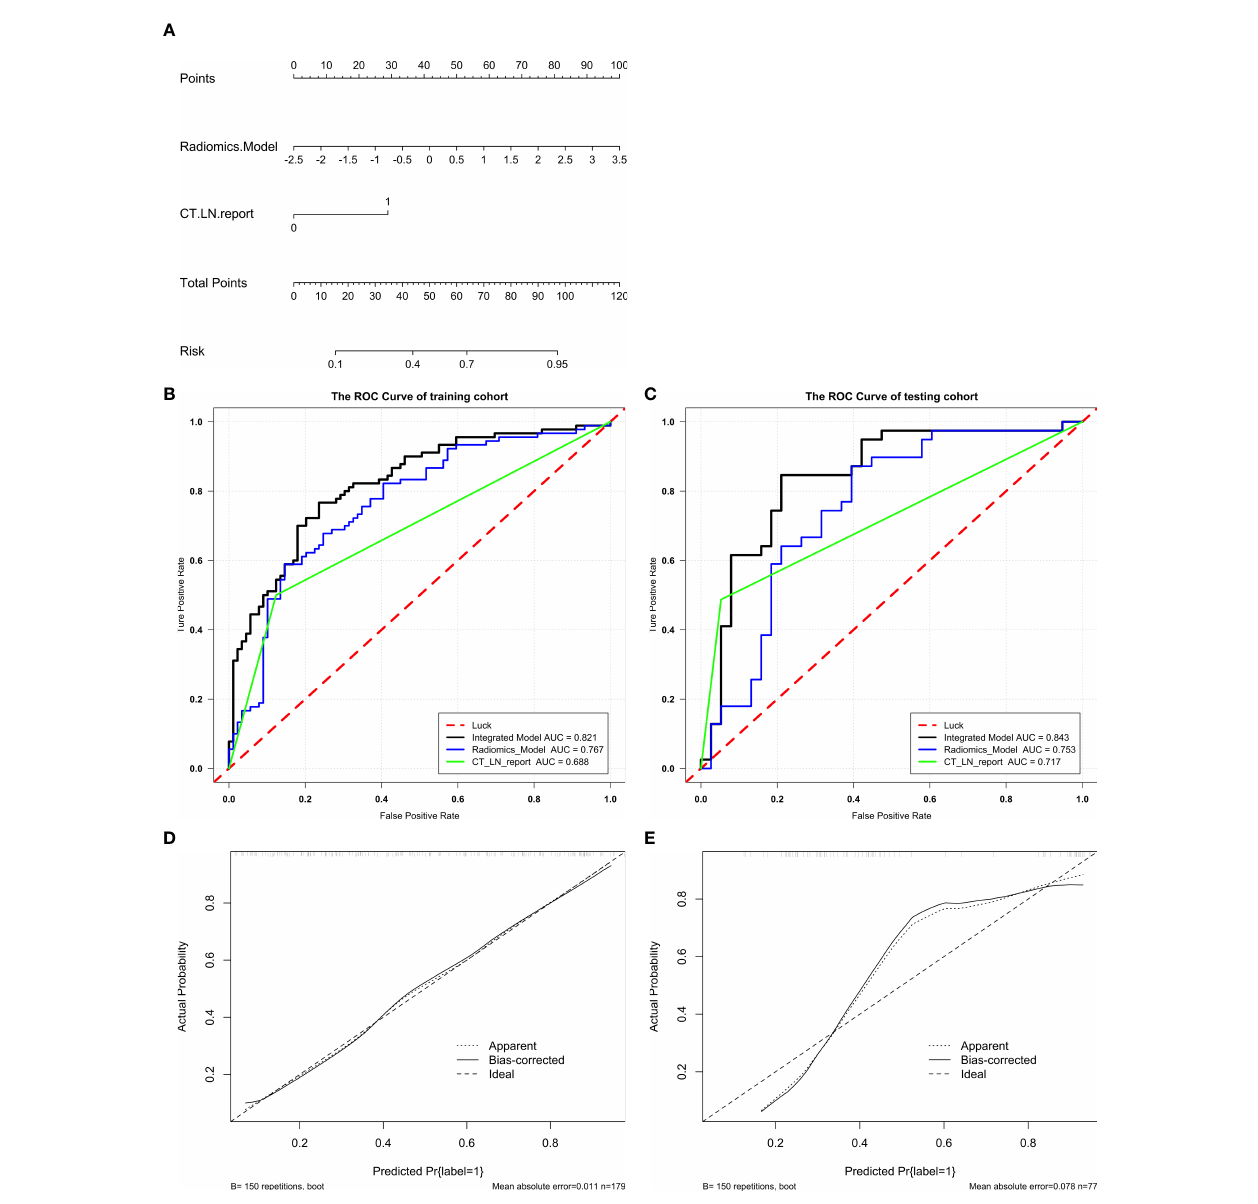
FIGURE 4 | Radiomics nomogram for the diagnosis of LN metastasis in patients with HGSOC. A radiomics nomogram was developed in the training (A) . Comparison of ROC curves among the Integrated Model, Radiomics Model, and CT_LN_report alone for the prediction of LN metastasis in the training (B) and test cohorts (C) . Calibration curves of the radiomics nomogram in the training (D) and test cohorts (E) . Good alignment of the diagonal dashed reference line and solid line indicates good